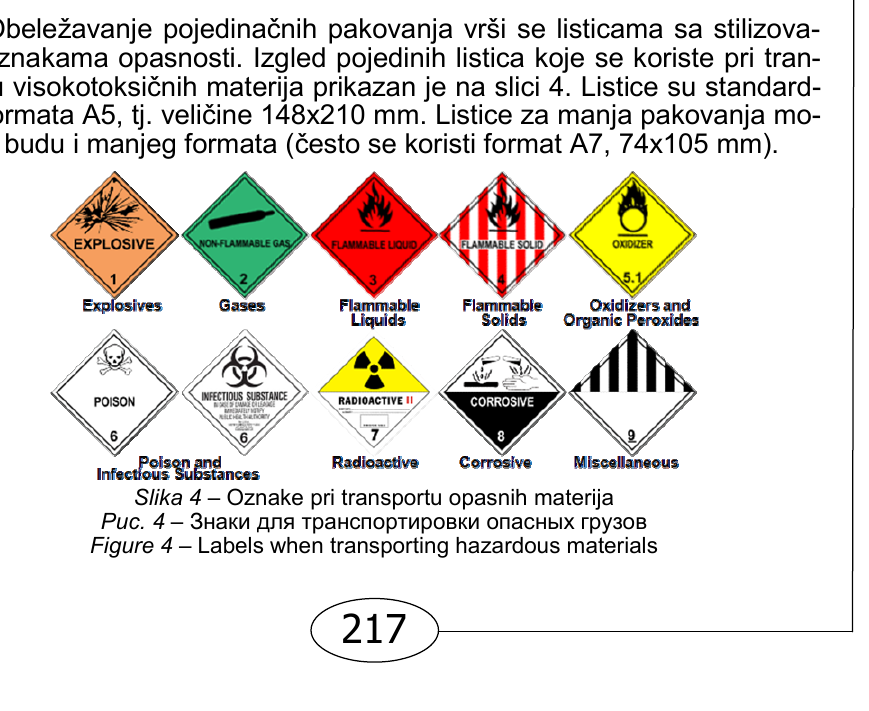
Рис . 3 – Вид таблички для транспорта грузов не входящих в список ООН Figure 3 – Table layout in the transport Figure 2 – Table layout in the transport of material that is not on the UN list of dietilbenzol